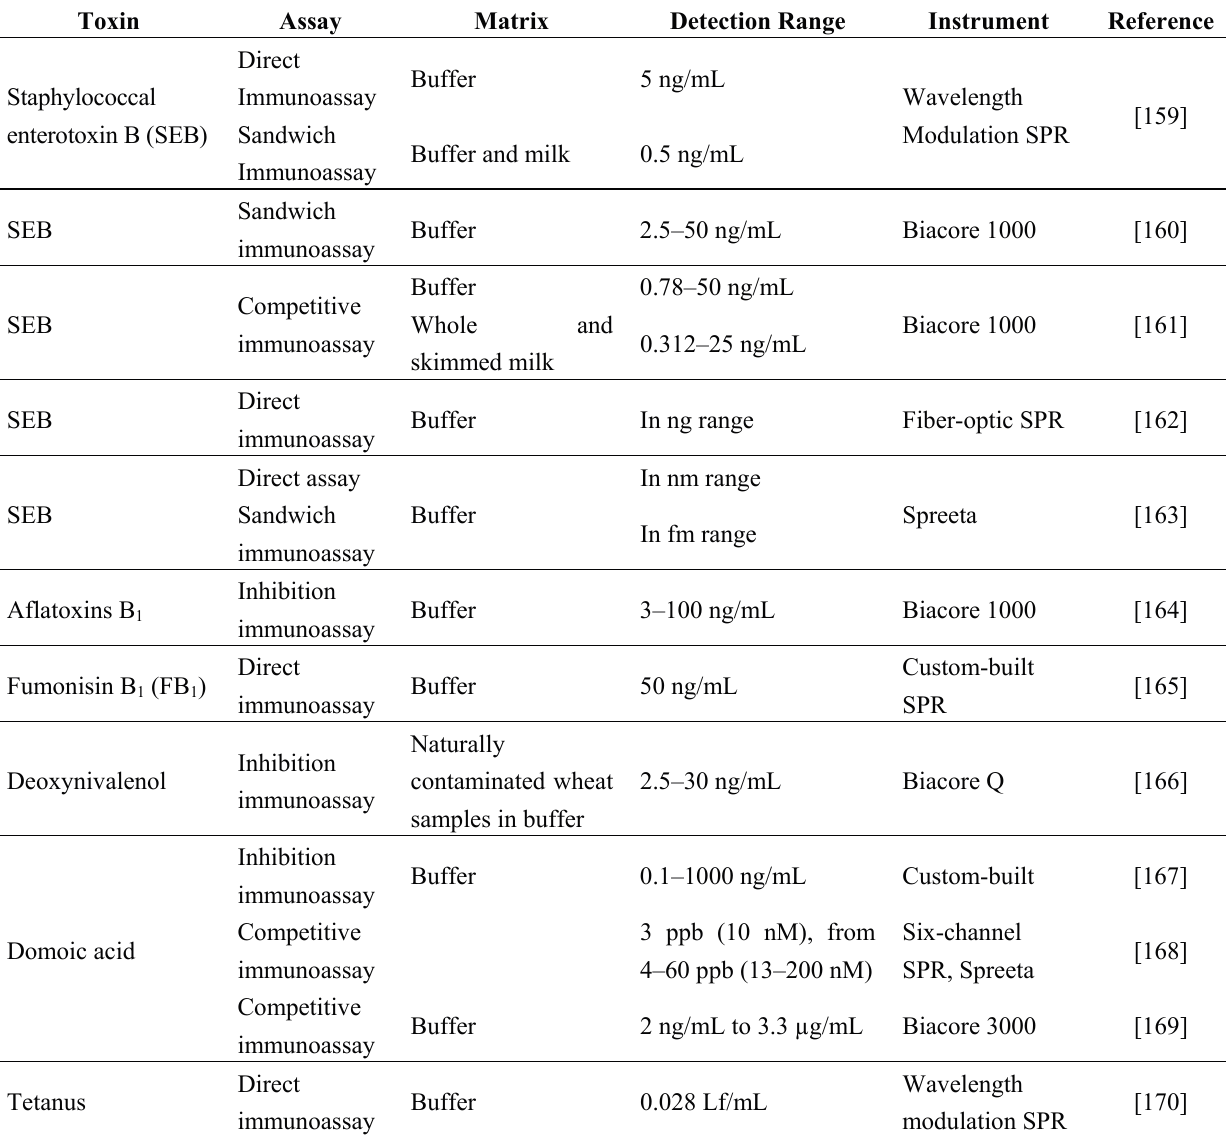
Table 7. Detection of toxins by SPR